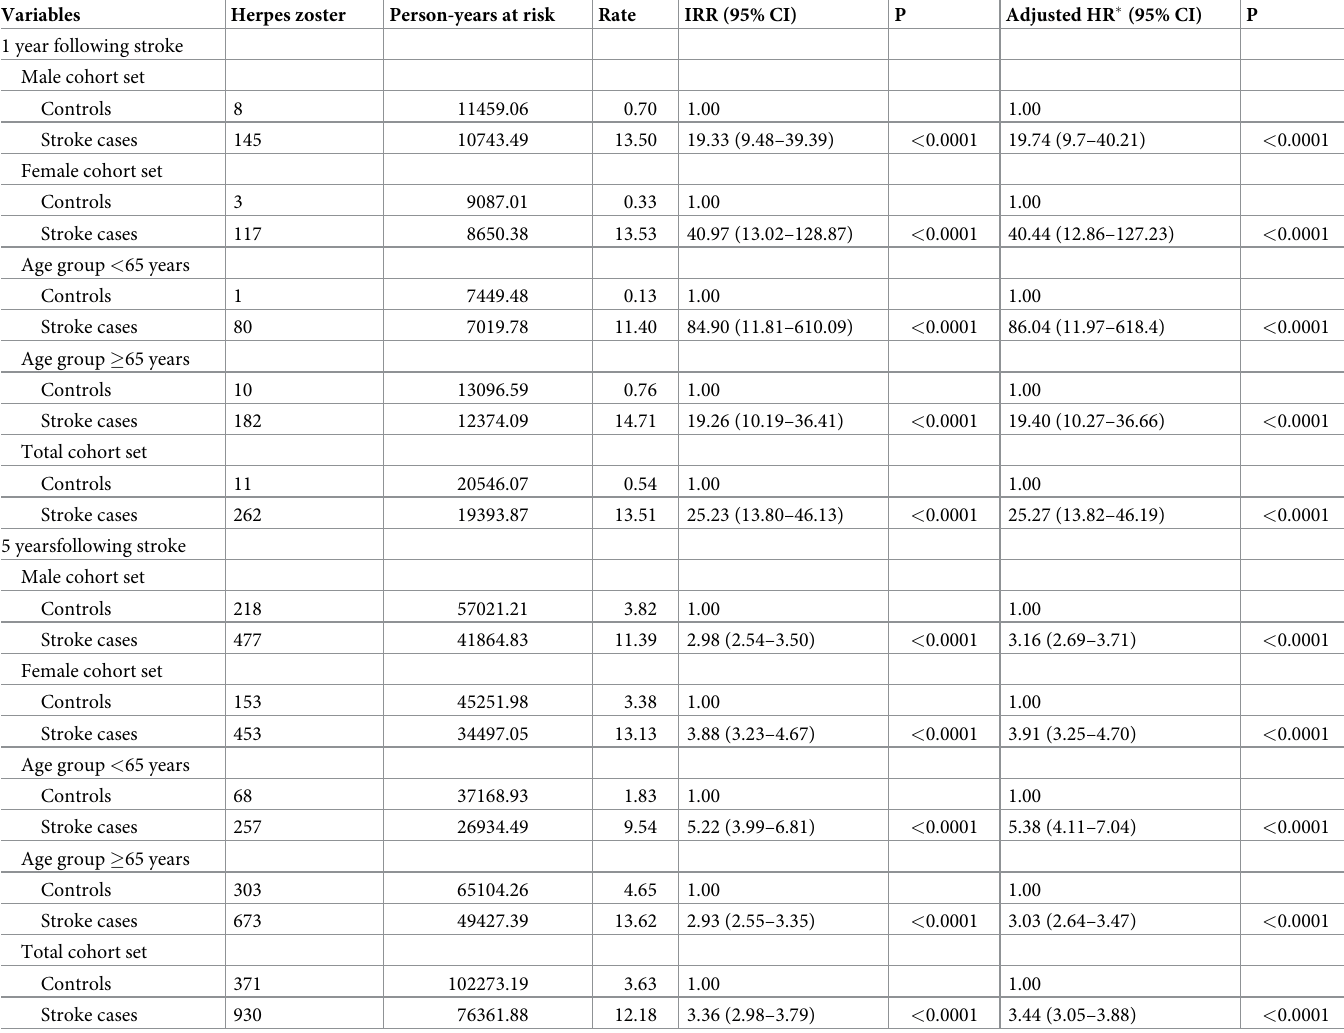
Table 2. Stroke associated with herpes zoster stratified by gender, age and by 1-year and 5-year follow-up period.